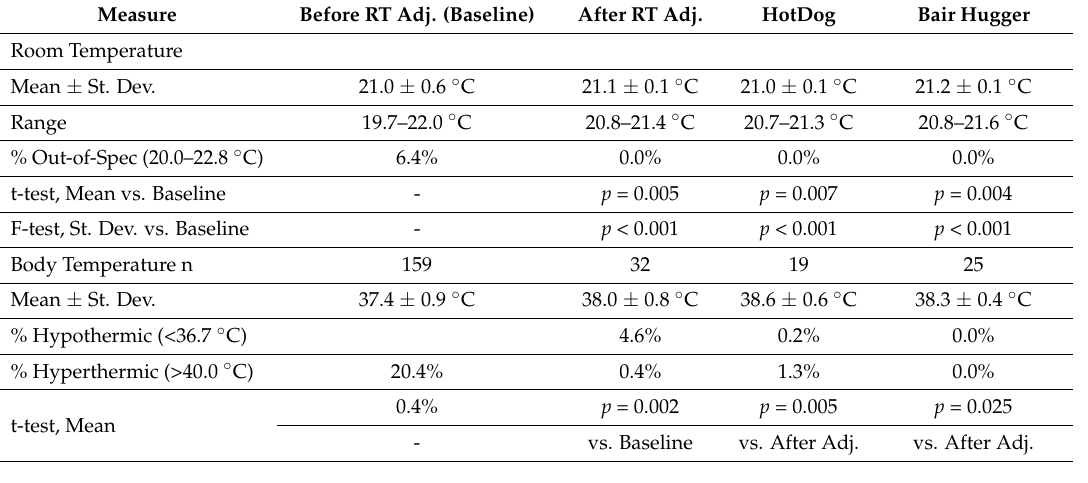
Table 1. Summary of temperature measurements.